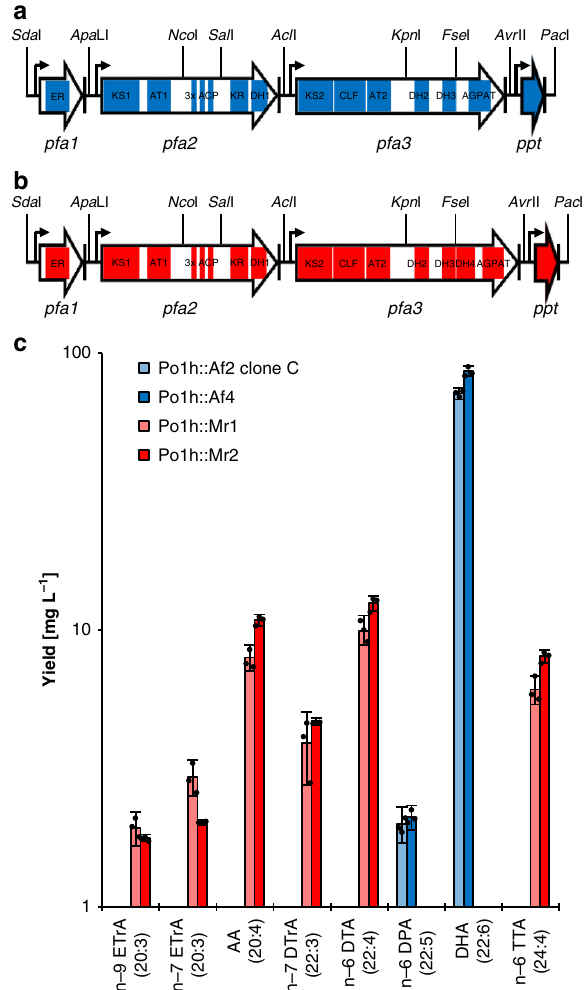
Fig. 2 Arti fi cial pfa biosynthetic gene clusters encoding myxobacterial PUFA synthases for LC-PUFA production in Yarrowia lipolytica Po1h. a Synthetic pfa BGC (20.2kb) version C1_V1 or C1_V2 comprising genes pfa1 , pfa2 , and